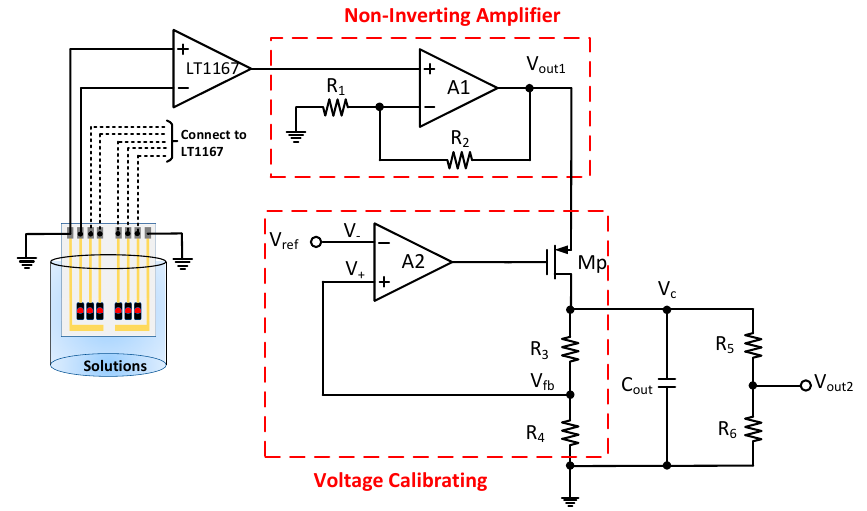
Figure 4. The structure diagram of the proposed new calibration circuit (NCC).